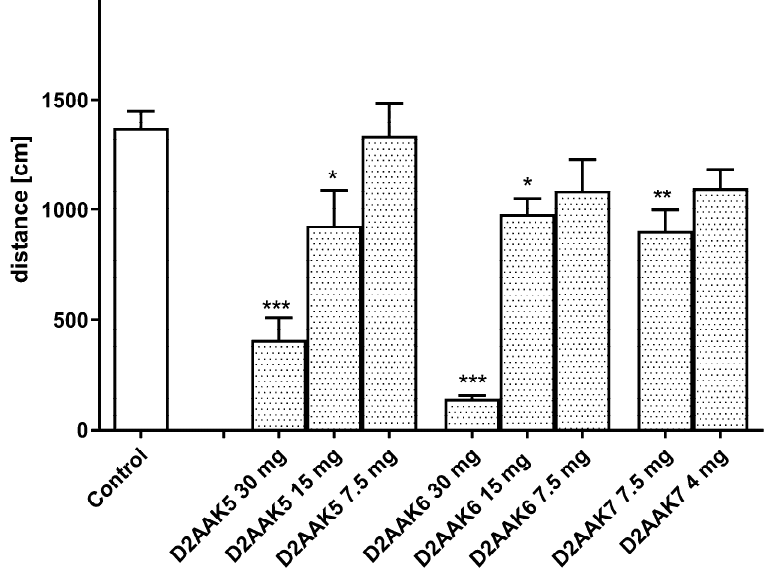
Figure 8. The influence of the tested compounds D2AAK5, D2AAK6 (30 mg, 15 mg and 7.5 mg/kg) and D2AAK7 (7.5 mg and 4 mg/kg) on the spontaneous locomotor activity of mice. Investigated compounds were injected i.p. 60 min before the test. Locomotor activity was measured after 20 min. Data are expressed as mean ± SEM values of the one independent experiment. * p < 0.05; ** p < 0.01; *** p < 0.001 vs. control (Dunnett’s post hoc test).